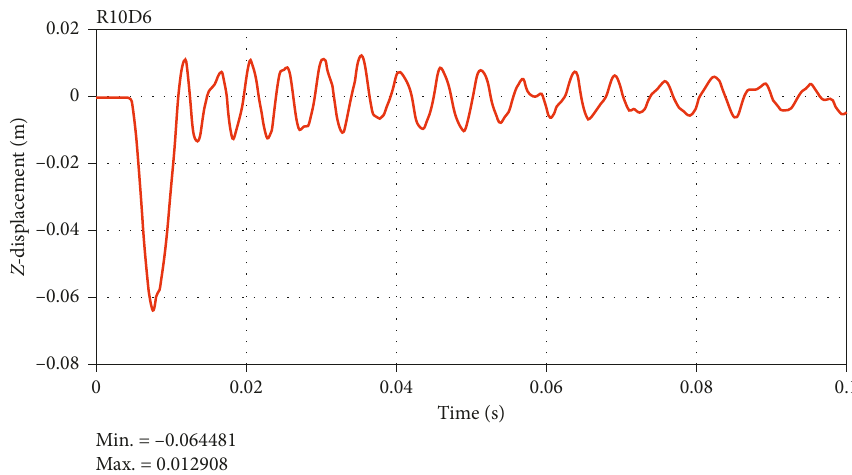
Figure 27: Time histories of the vertical displacement of impact point.